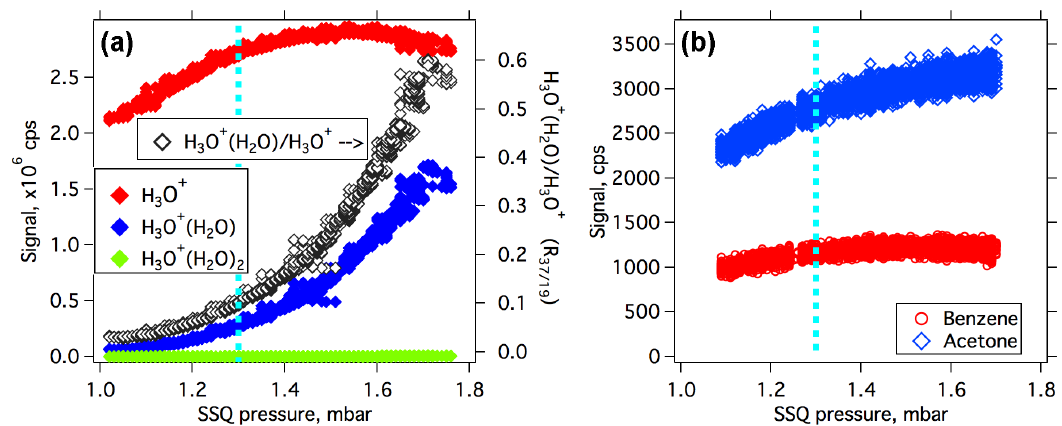
Figure 2. (a) Signals of reagent ions and H 3 O + (H 2 O) / H 3 O + ratio ( R 37 / 19 ) as a function of SSQ pressure. (b) Signals of protonated benzene and acetone at constant mixing ratios of 2.5ppb as a function of SSQ pressure. The light blue vertical dashed lines indicate the SSQ pressure (1.30mbar) used during the SONGNEX